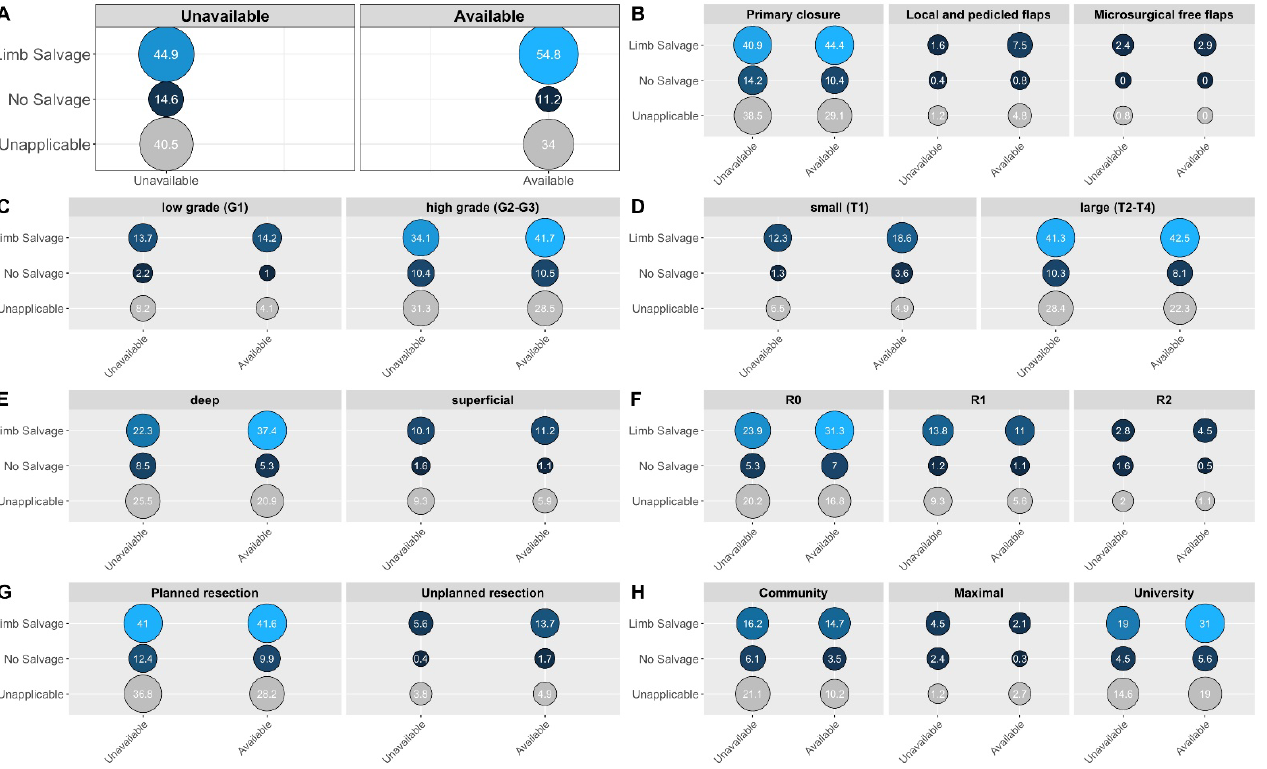
Figure 2. Balloon plots of exploratory subgroup analyses illustrating higher limb-salvage rates (rows, bottom row level “unapplicable” represents non-extremity sarcomas) with availability of plastic and reconstructive surgery services (columns). Accordingly, centers with readily available plastic surgeons were associated with a significantly higher overall chance of limb salvage (pooled OR = 1.43, 95%CI = 1.03–2.06, p = 0.035) ( A ). Further surgical subgroup differences impacting this association included: type of defect closure ( B ), tumor grading (unequivocally classified cases not shown) ( C ), tumor size (unequivocally classified cases not shown) ( D ), tumor depth (unequivocally classified cases not shown) ( E ), and margins of first resection (cases of unknown or unclear margins not shown) ( F ). Numbers represent column-wise cumulative percentages.